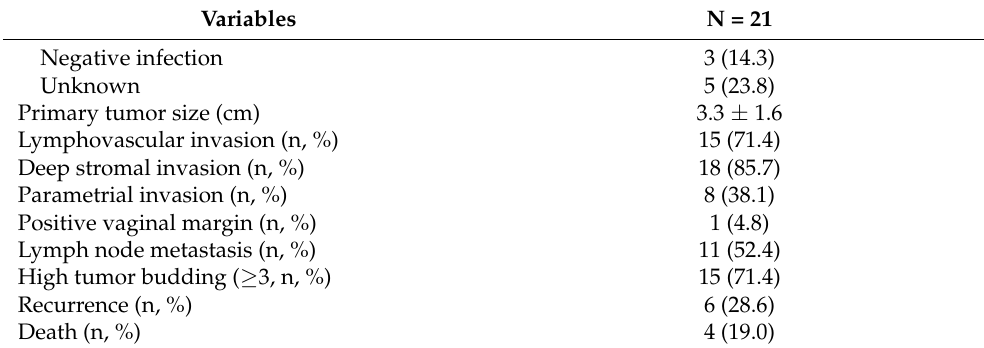
FIGO = International Federation of Gynecology and Obstetrics; HPV = human papilloma